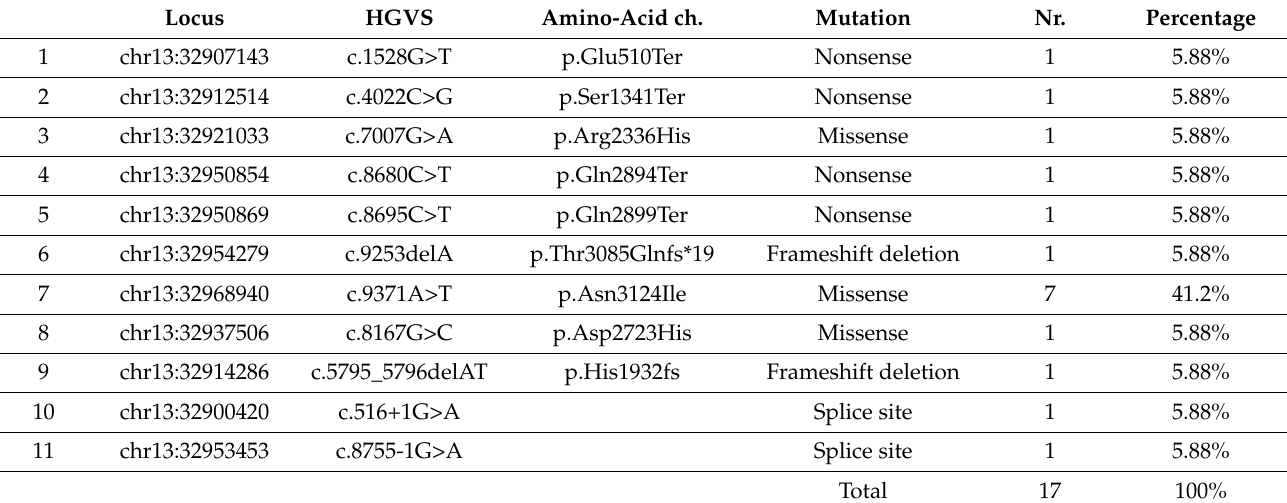
Table 6. BRCA2 mutations (according to the HGVS) and their links to BC in the analyzed